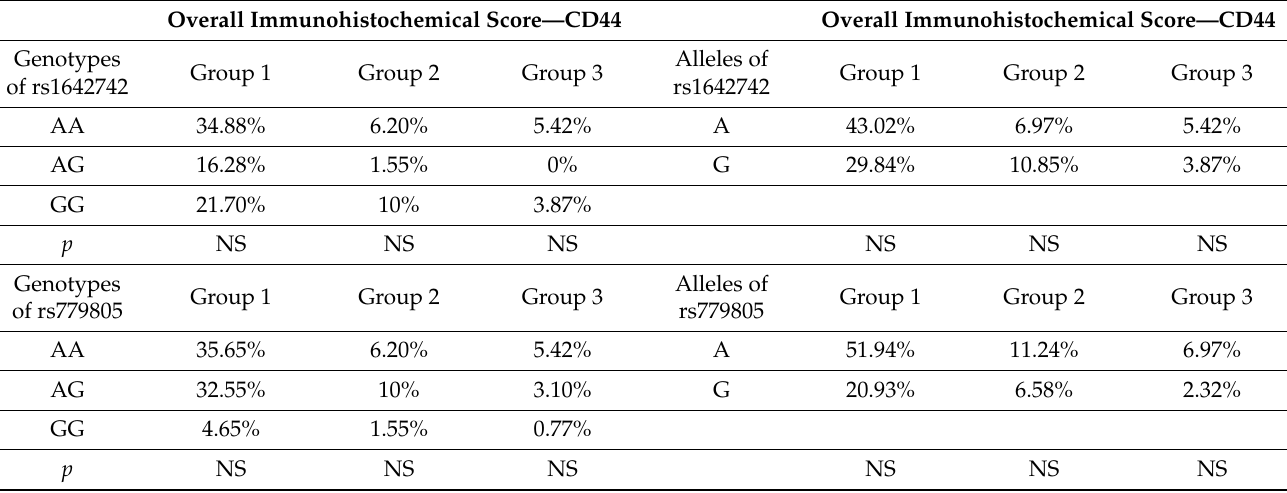
Table 6. Associations of the VHL polymorphisms with CD44, MMP-2 and MMP-9 expression